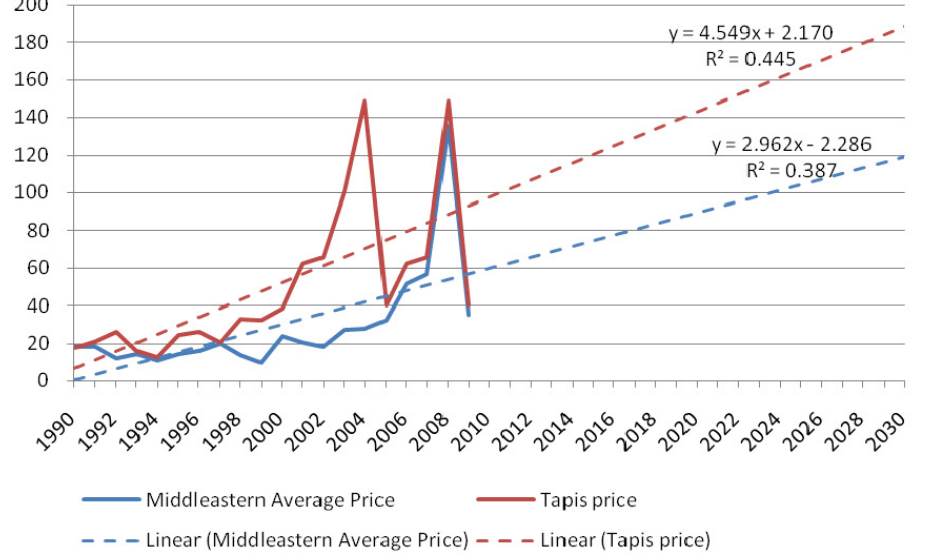
Figure 10. Assumed behaviors of oil prices (dash lines) and their historical data (solid lines) (Source: